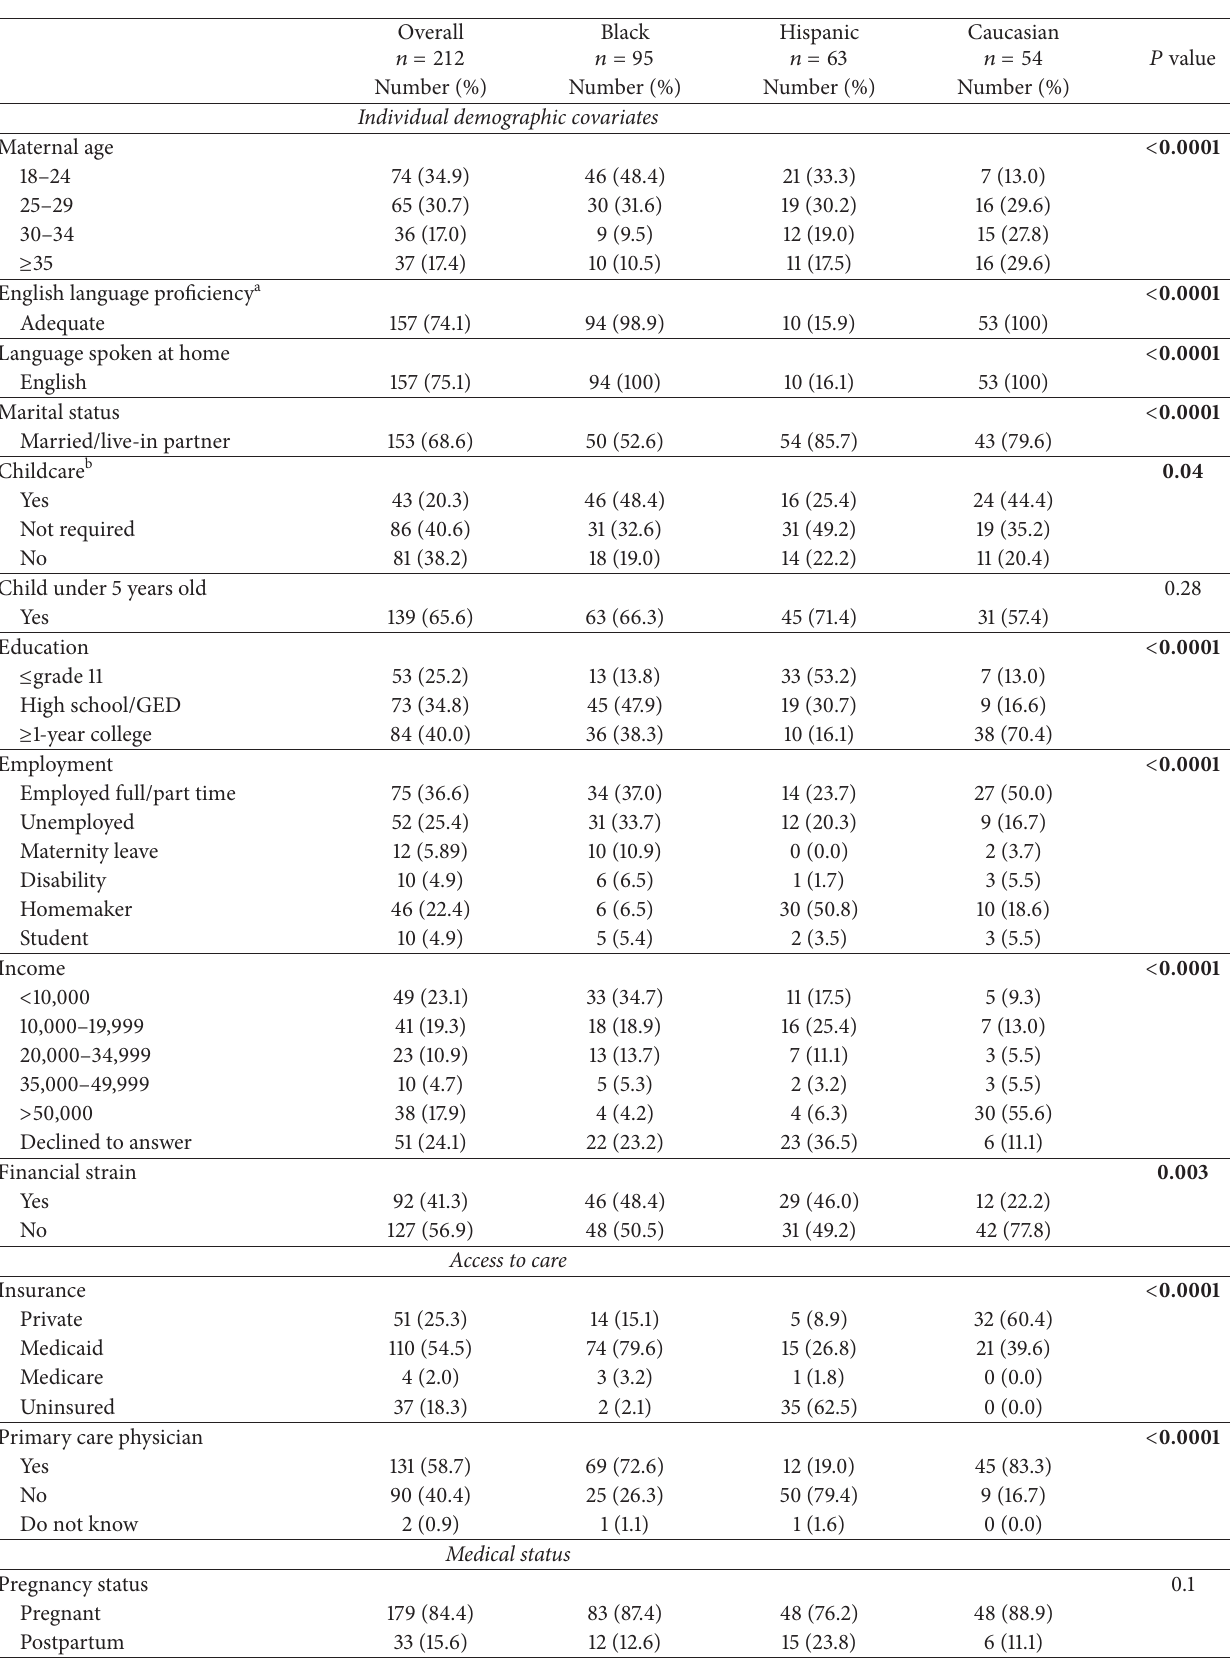
Table 1: Characteristics of pregnant and postpartum women by race/ethnicity ∗